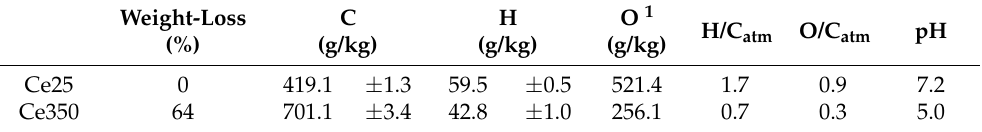
Table 1. Elemental composition, atomic H/C (H/C atm ) and O/C (O/C atm ), pH of cellulose (Ce25) and its pyrochar (Ce350) produced by pyrolysis at 350 ◦ C for 1